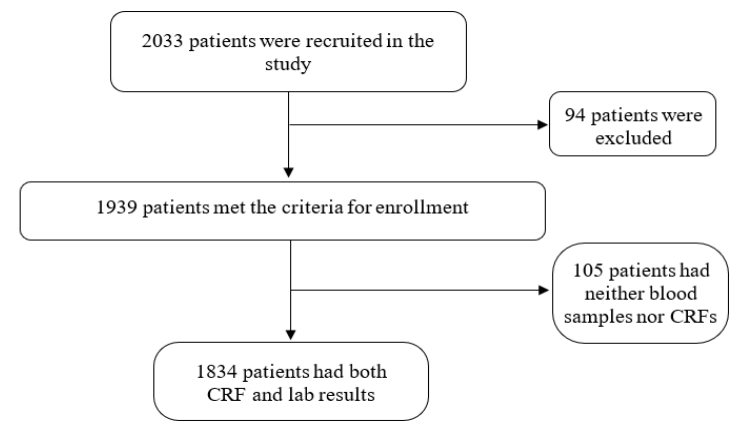
Figure 1. Enrollment flow of the study.